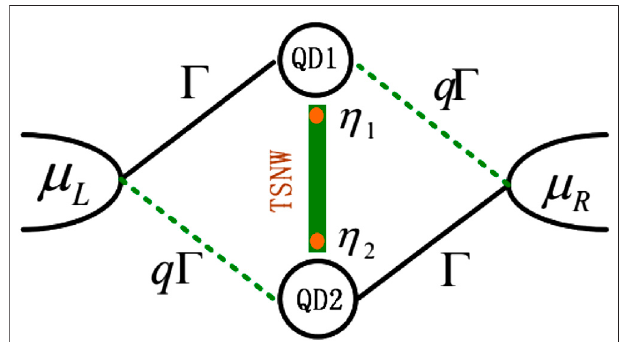
FIGURE1| Schematic plotoftheparalleldoubleQDscoupled tothe left and right leads with coupling strength Γ L / R ij , and to each other by a TSNW hosting MBSs. Dot 1(2) couples to the mode η 1(2) of the MB η Ss with hybridization strength λ 1(2) . The chemical potentials of the leads are μ L and μ R , which are set to be μ L (cid:1) μ R (cid:1) 0 in the linear response